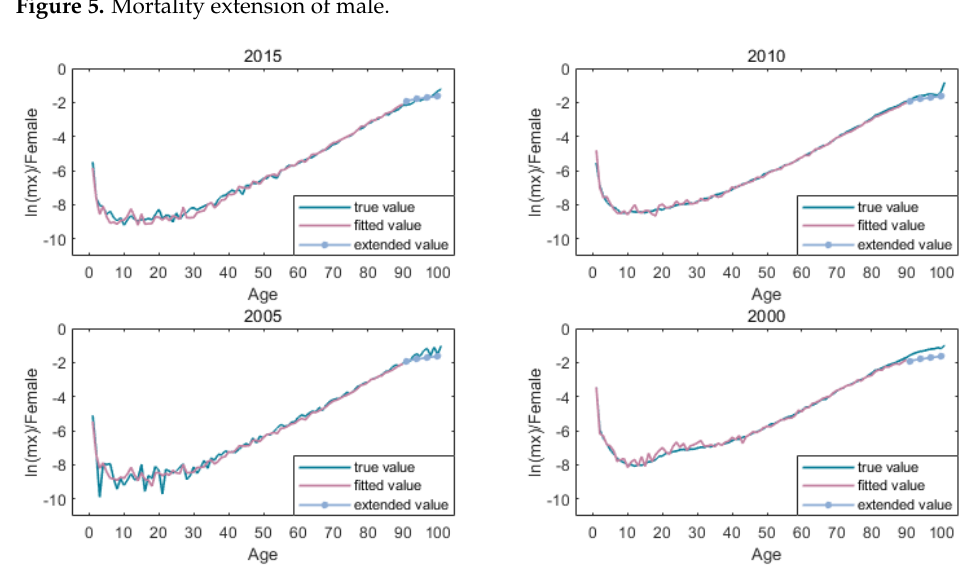
Figure 5. Mortality extension of male.